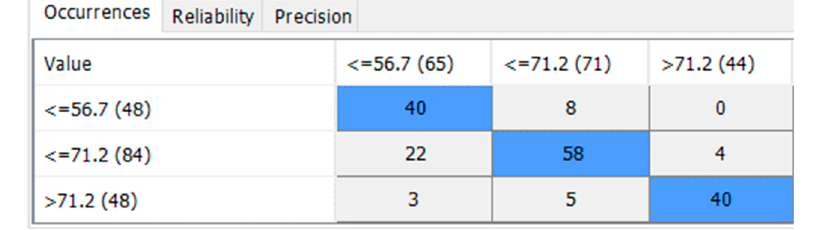
Figure 8. Confusion matrix of occurrences.